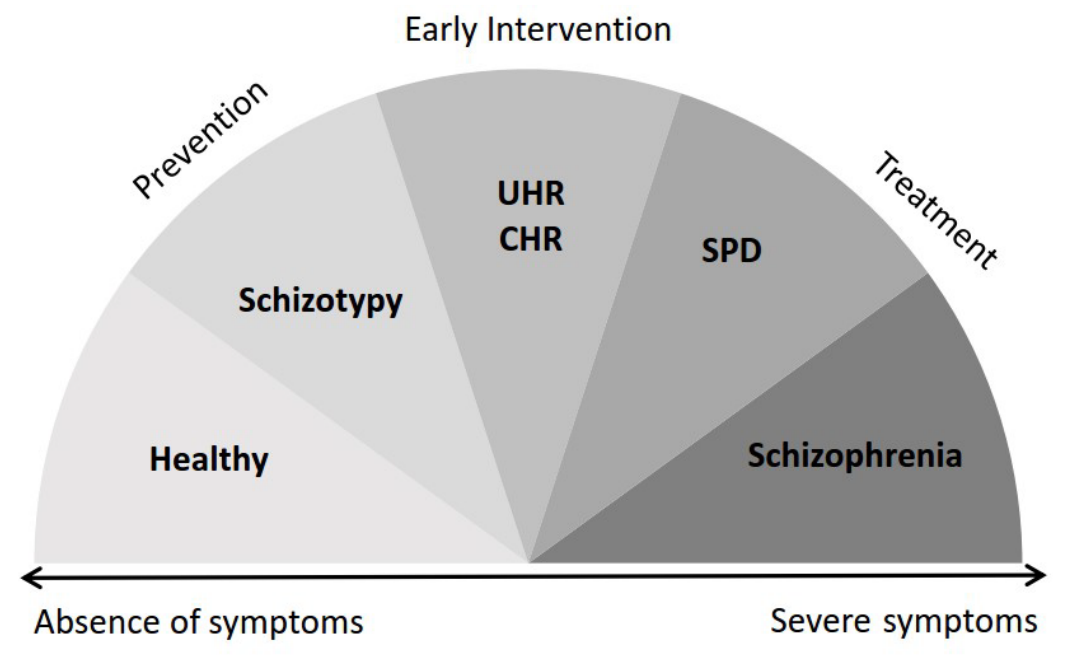
Figure 1. The Schizophrenia Spectrum. Abbreviations: UHR = Ultra High Risk, CHR = Clinical High Risk, SPD = Schizotypal Personality Disorder.